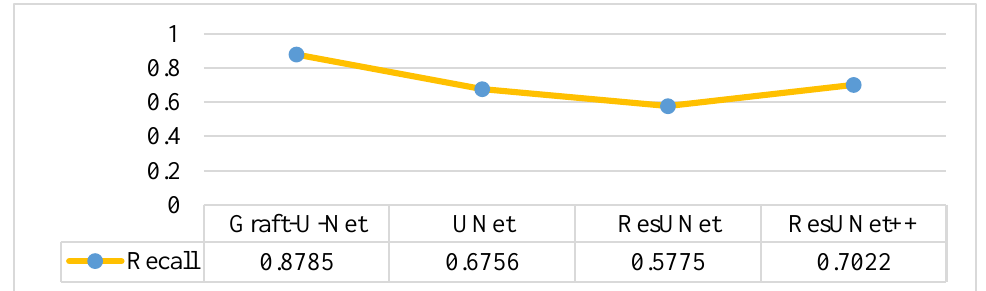
Figure 14. Comparison of Graft-U-Net on CVC-ClinicDB Dataset in terms of Recall. The results of Graft-U-Net (0.9211) in terms of Precision are compared with the exist-